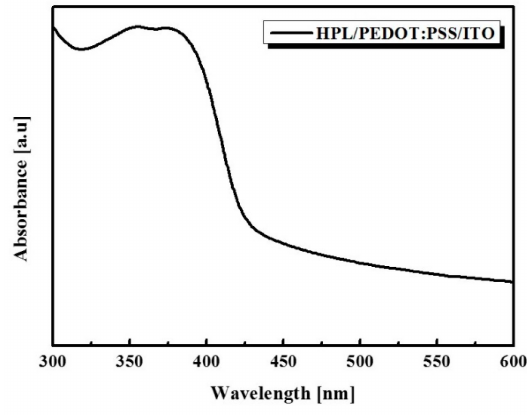
Figure 4. UV-vis absorption spectrum of HPL/PEDOT:PSS